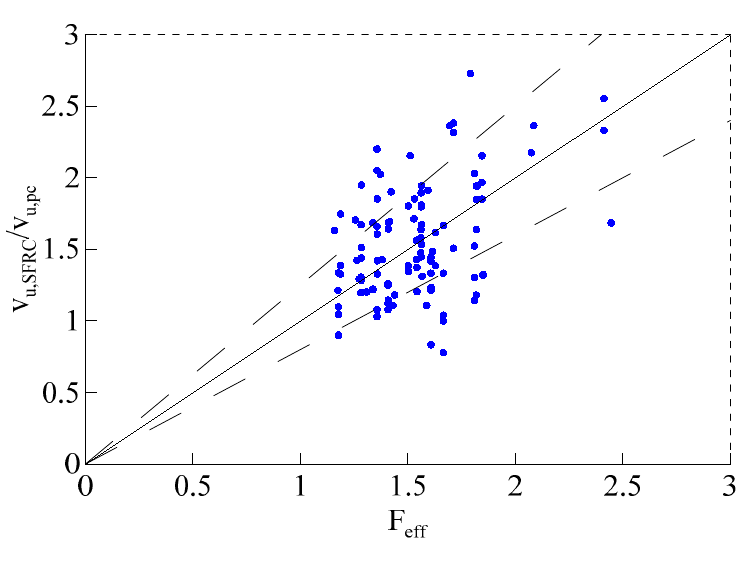
Comparison between V c,SFRC /V c,pc and fiber effectiveness factor Proposed fiber e ff ectiveness factor equation and comparison between SFRC shear Figure 8. Proposed fiber effectiveness factor equation and comparison between SFRC shear strength-to-normal concrete shear strength ratios and proposed fiber e ff ectiveness strength-to-normal concrete shear strength ratios and proposed fiber effectiveness factor.